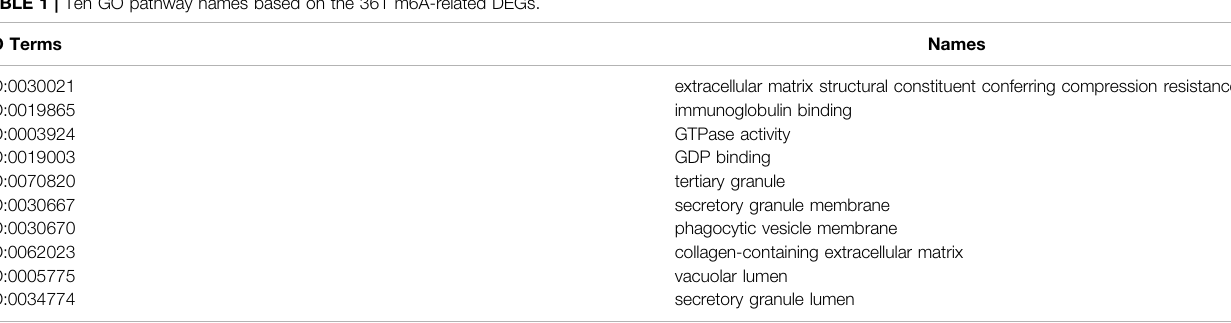
TABLE 1 | Ten GO pathway names based on the 361 m6A-related